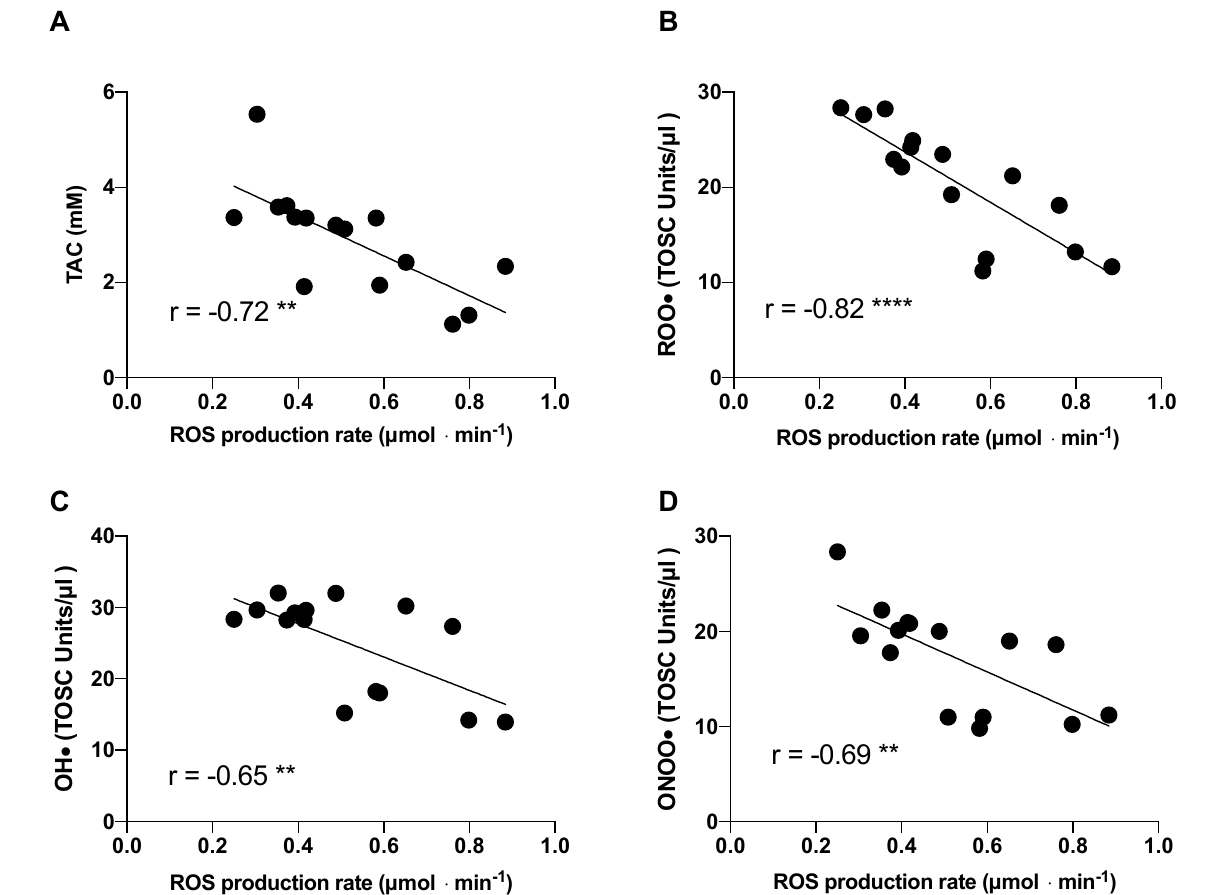
Figure 4. Multipanel plots of ROS production rate levels relative to ( A ) TAC, ( B ) ROO • , ( C ) OH • , and ( D ) ONOO • . The linear regression fit (solid line) is also shown and so is the correlation coefficient (r) reported in each panel. A significant linear relationship was estimated as ** p < 0.01; **** p < 0.001.